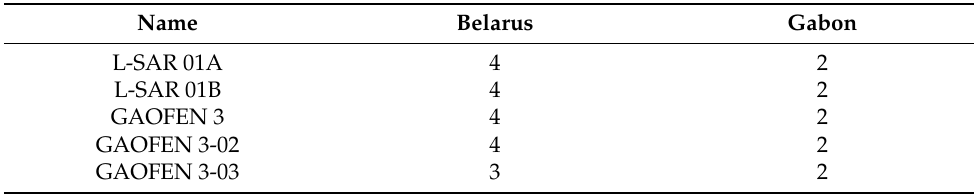
Table 3. Number of observation